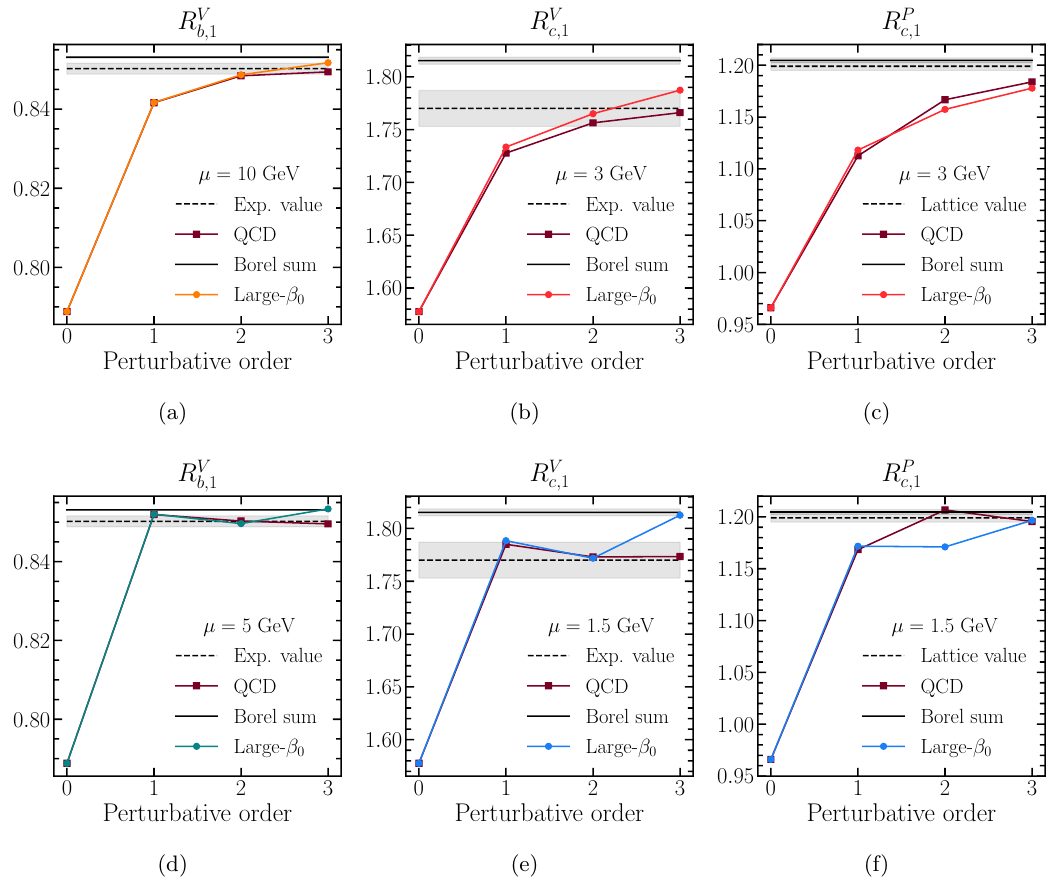
Figure 6 . Perturbative series for exemplary ratios of moments in large- β 0 and full QCD for µ ∼ 2 m q (upper panels) and µ ∼ m q (lower panels). The solid horizontal line represents the large- β 0 Borel sum while the dashed lines are the values of the ratios obtained from experimental data = 0 . 8502 ± 0 . 0014 , R V = 1 . 770 ± 0 . 017 [10, 11] or lattice simulations R P R V c, 1 b, 1